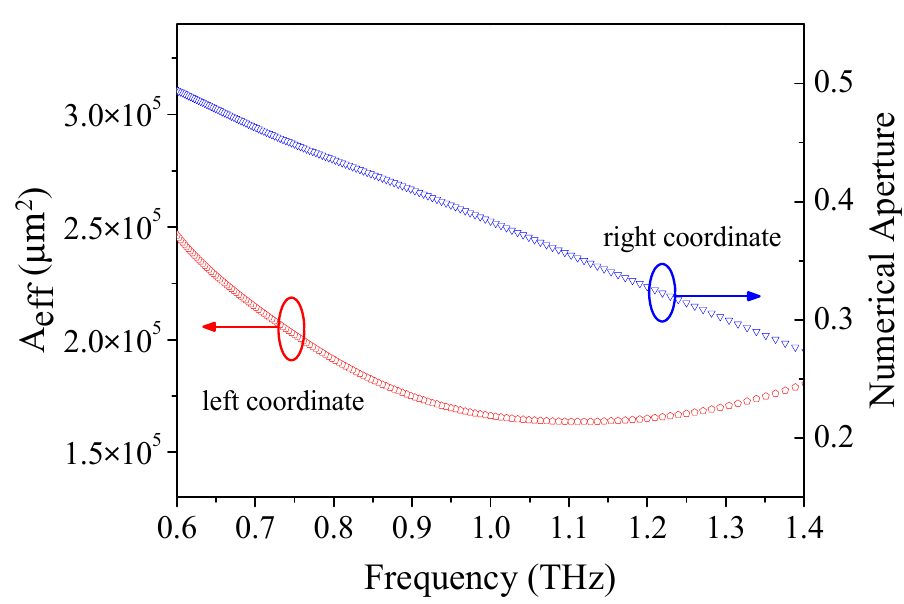
Figure 9. The relation of effective mode area and numerical aperture with frequency.